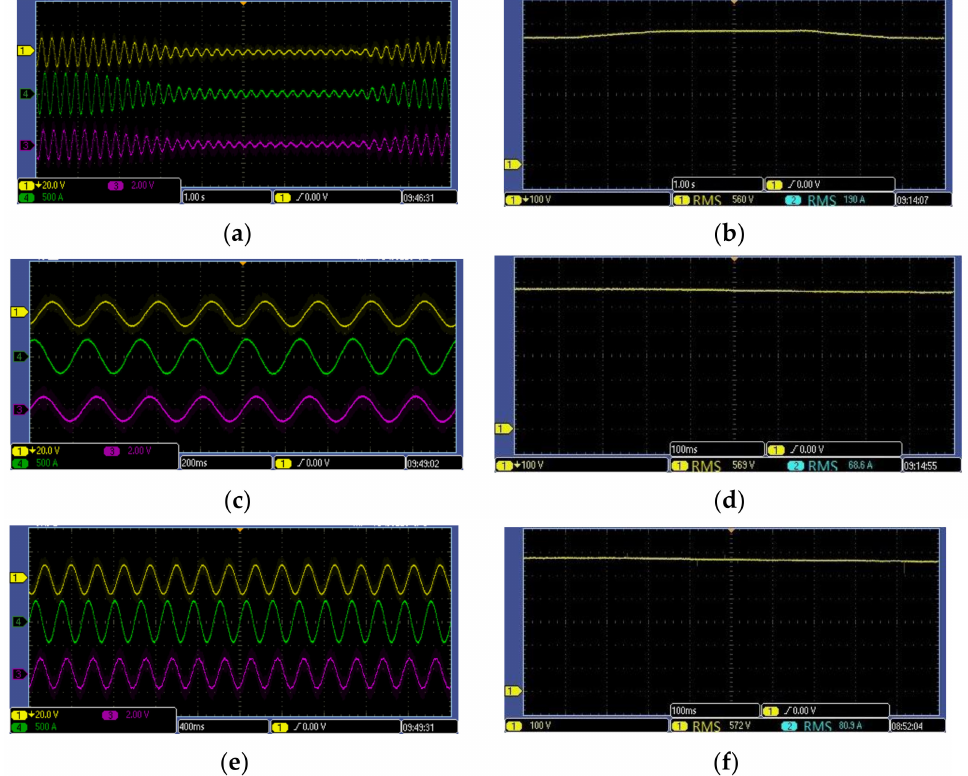
Figure 15. Experimental results in the faulty operation with reconstructing topology. ( a ) the output currents; ( b ) the DC-side voltage ; ( c ) the output currents in the forward operation; ( d ) the DC-side voltage in the forward operation; ( e ) the output currents in the reverse operation; ( f ) the DC-side voltage in the reverse